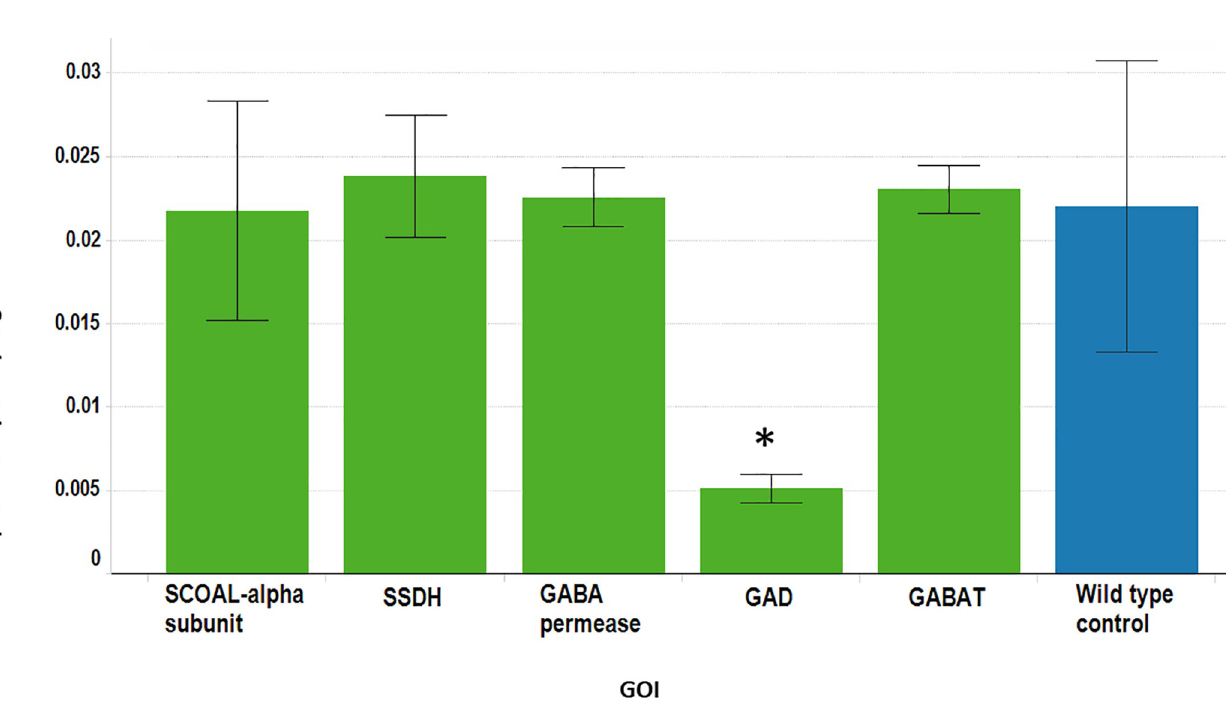
PLOS ONE | https://doi.org/10.1371/journal.pone.0259365 December6,